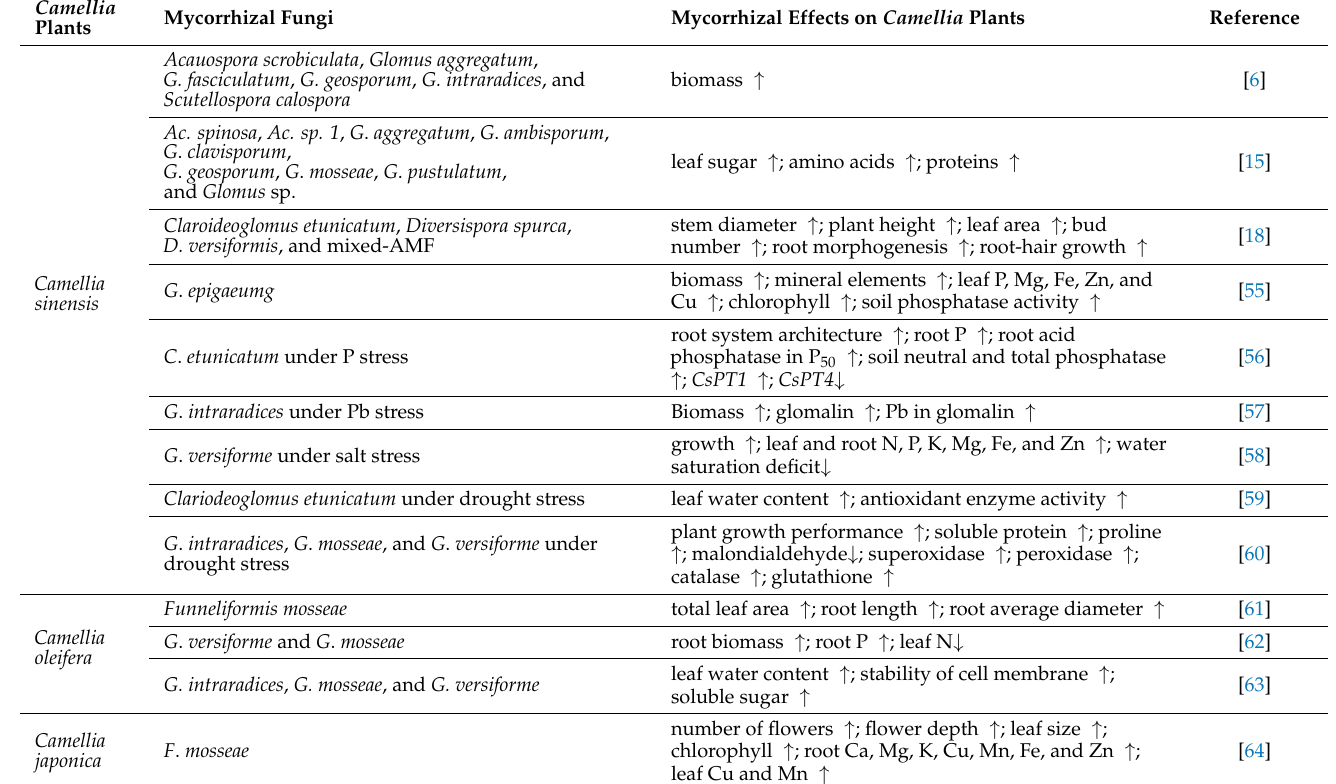
Table 2. Roles of AMF fungi in Camellia